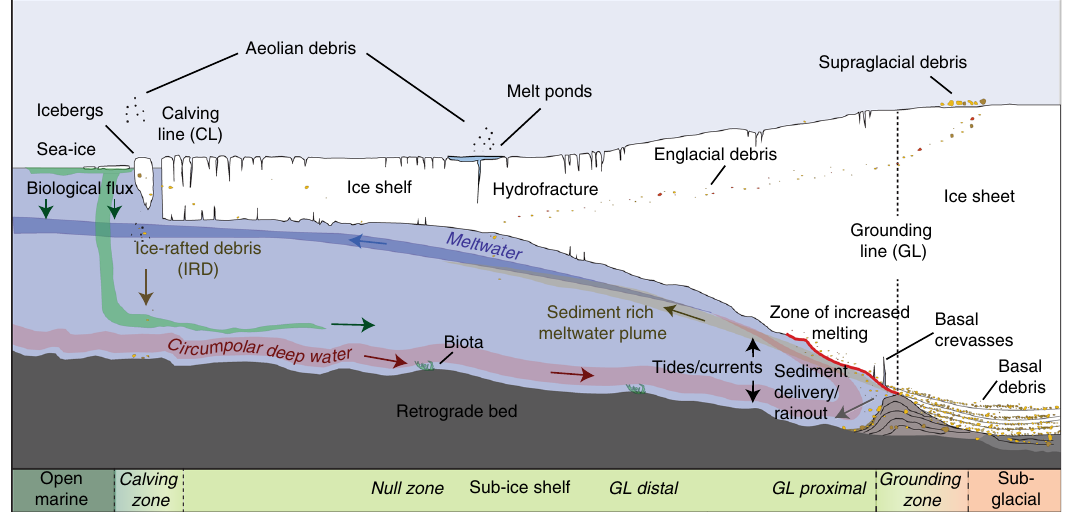
Fig. 2 Simpli fi ed view of an Antarctic ice shelf in fl uenced by warm water in fl ow (not to scale). In fl owing warm water drives enhanced melting at the ice- shelf base in the vicinity of the grounding line (GL) and results in out fl owing meltwater that is cooler and